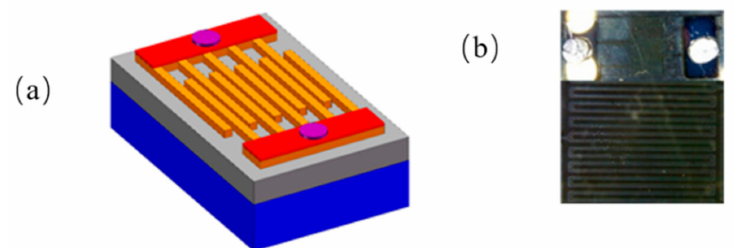
Figure 1. ( a ) The diagrammatic structure of the UVPDs, ( b ) The schematic full view of the interdigital metal electrodes of the UVPDs.